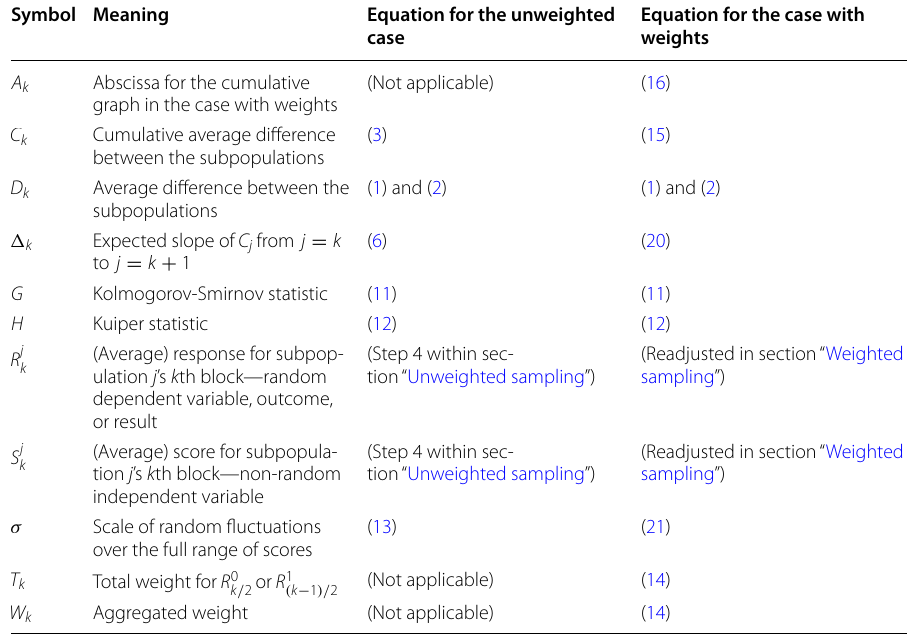
Table 1 Notational conventions (The symbols in the table are in alphabetical order.) Symbol Meaning Equation for the unweighted Equation for the case with case